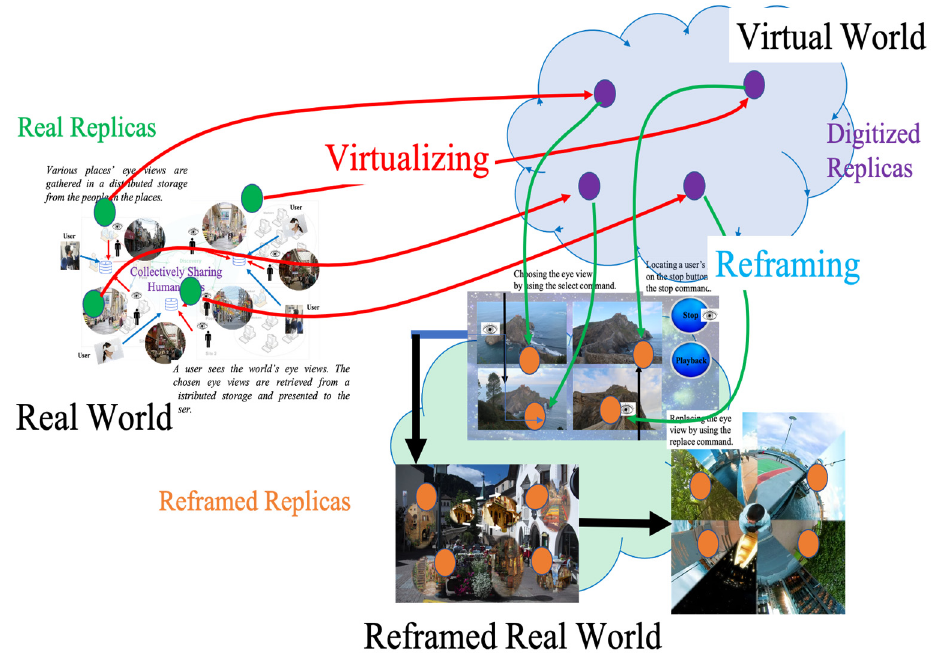
Figure 5. A V/R Twin Mode for CollectiveEyes.